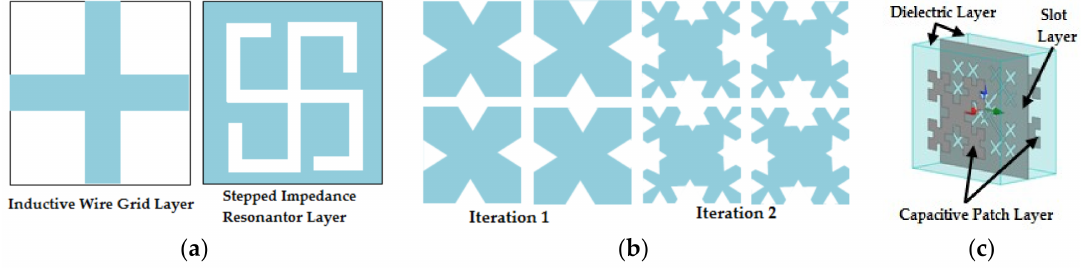
Figure 10. ( a ) Pattern of two compact resonating layers of FSS ( b ) Elements of double screen Koch FSS ( c ) Structural diagram of FSS based on complementary Minkowski Fractal elements.